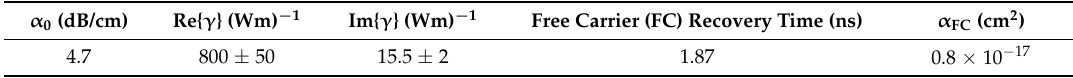
Table 1. a-Si waveguide optical characteristics determined in [28].